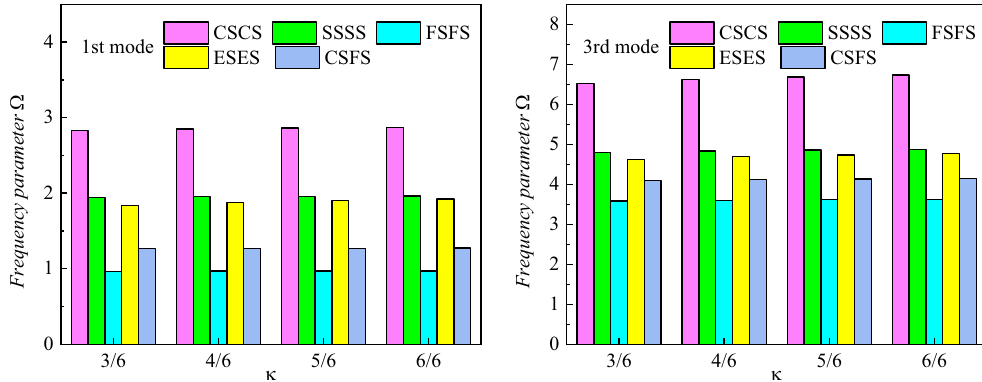
Figure 7: Frequency parameters Ω of rectangular plate with di ff erent shear correction factors.